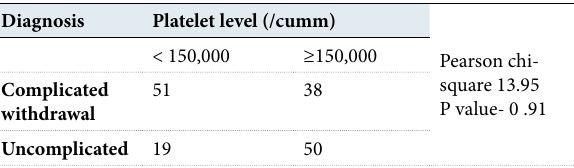
Table 2: Platelet value among complicated and uncomplicated alcohol dependence syndrome Diagnosis Platelet level (/cumm)